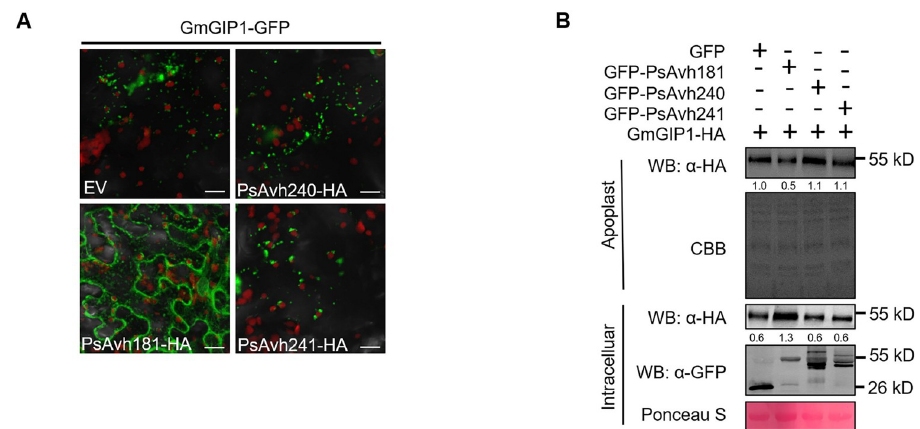
Fig 1. Secretion of GmGIP1 can be inhibited by PsAvh181. (A) Subcellular localization of PsAvh181-HA, PsAvh240-HA, PsAvh241-HA or empty vector when co-expressed with GmGIP1-GFP 48 h after agroinfiltration and investigated using confocal microscopy. Each confocal microscopy picture represents a stack of 16–30 single slices. Scale bar, 20 μ m. (B) Accumulation of GmGIP1-HA in the apoplast when co-expressed with GFP-PsAvh181, GFP- PsAvh240, GFP-PsAvh241 or GFP. The extracted apoplast fluid and total proteins were detected by western blot using anti-GFP (Abmart) and anti-HA (Abmart) antibodies. Apoplastic extracts were stained with Coomassie Brilliant Blue (CBB), and intracellular extracts were stained with Ponceau S. Numbers below the blot indicate relative abundances of GmGIP1-HA.